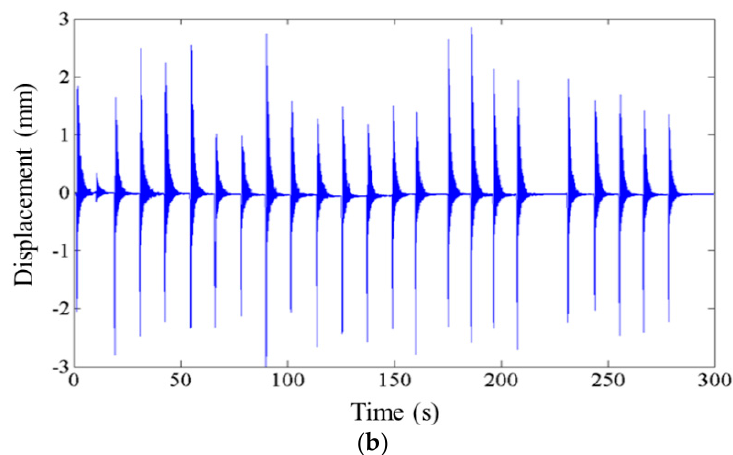
Figure 10. Some experimental data samples at Point A2. ( a ) Impact velocity with respect to time; ( b ) displacement with respect to time.